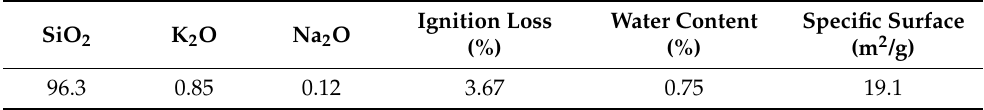
Table 2. Chemical composition and physical properties of silicon powder.